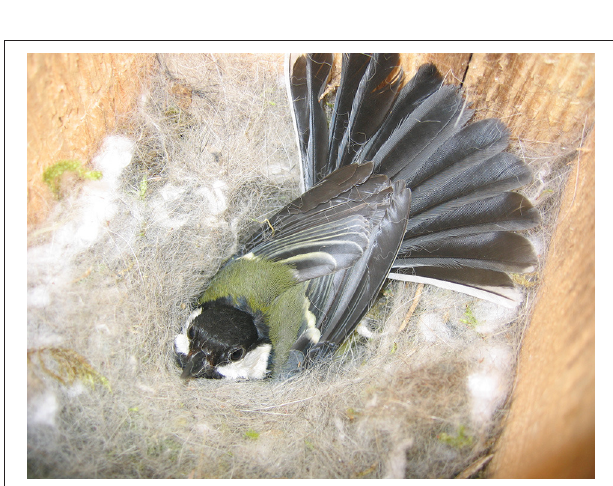
FIGURE 2 | Female great tit incubating eggs (Photo: Ian R.